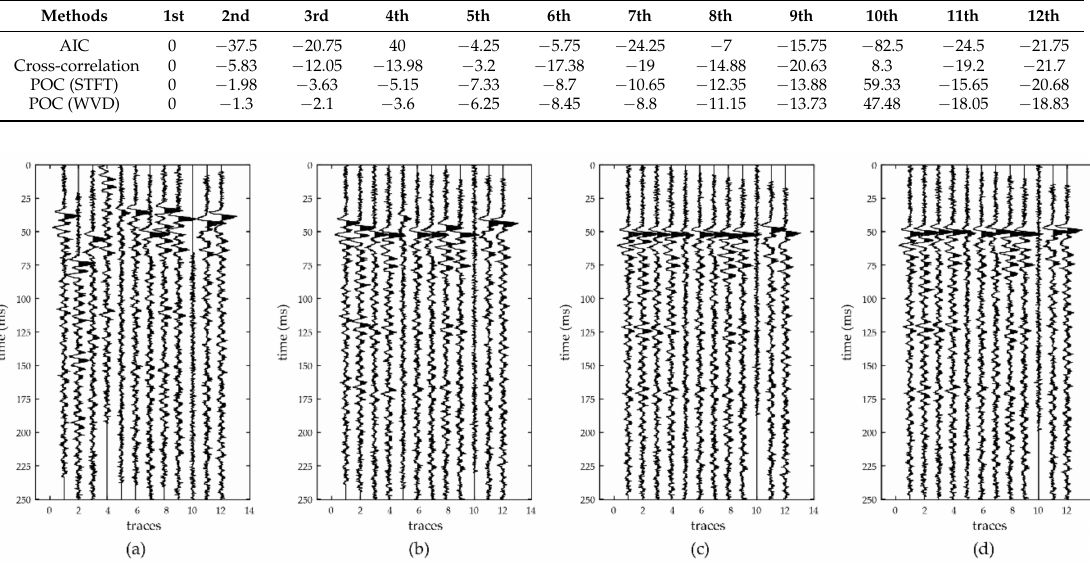
Table 7. The estimated values of the relative arrival times of the second noisy dataset (SNR = 0 dB).